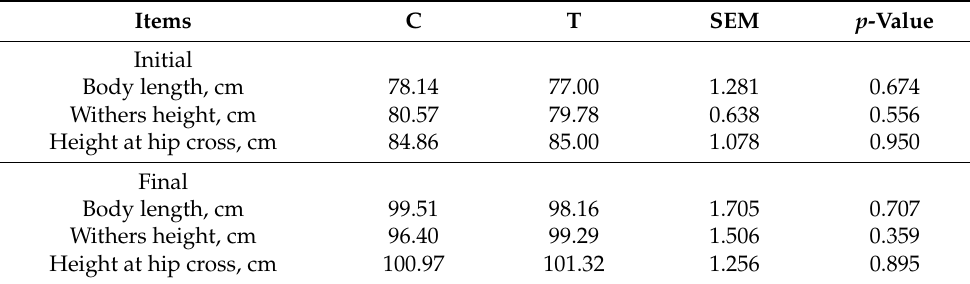
Table 5. Effects of supplemental resveratrol on the body size of Hanwoo